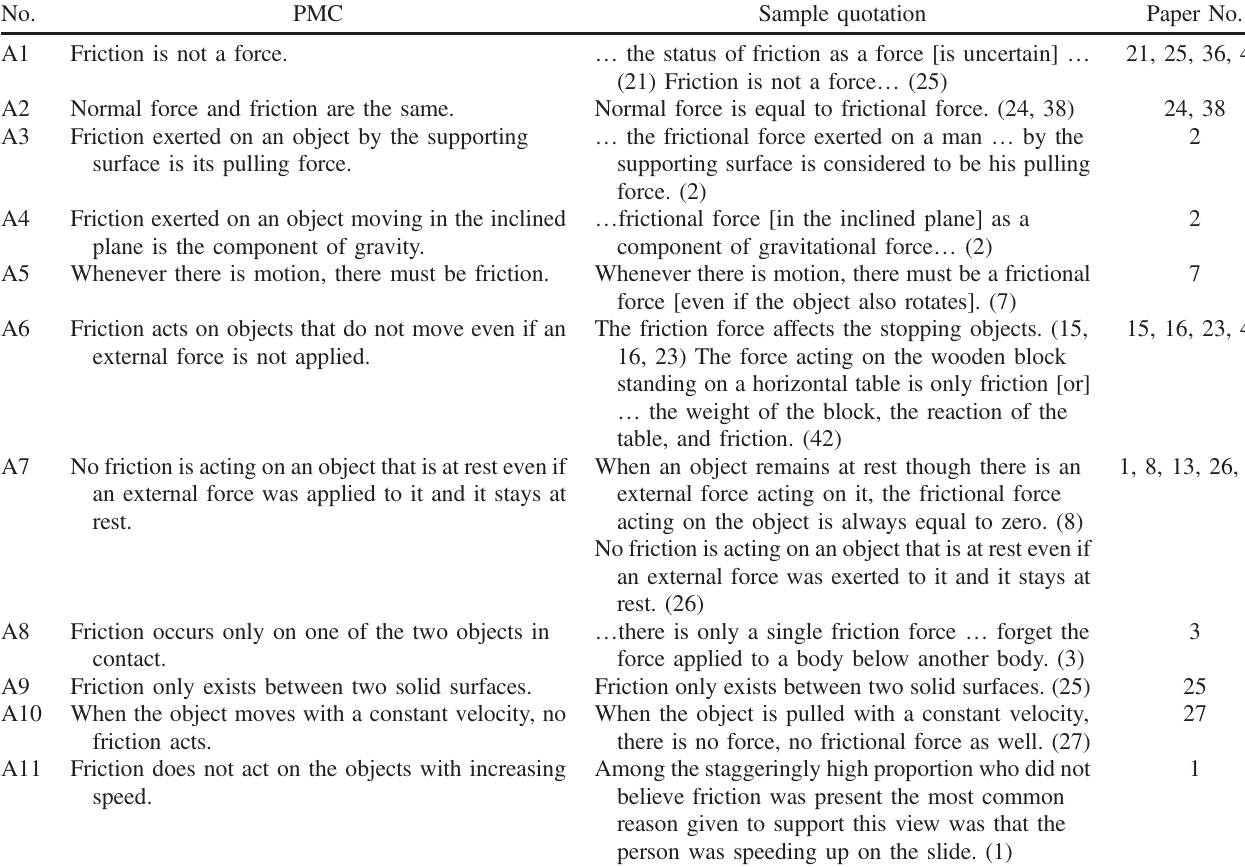
TABLE III. PMCs related to the definition and existence of friction. No. PMC